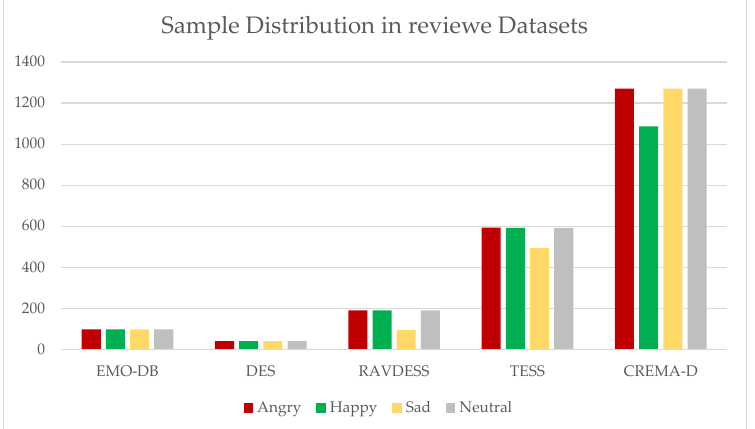
Figure 1. Comparison of the distribution of similar emotions from the reviewed simulated